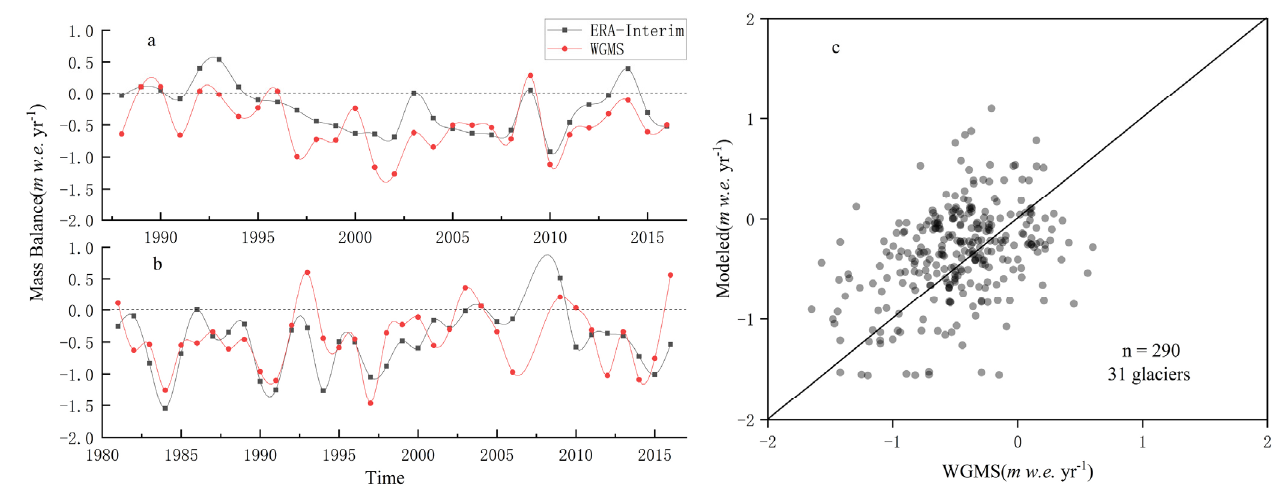
Figure 2. Accuracy evaluation of the PyGEM simulated data. Comparison of the average annual mass balance between the PyGEM-Interim simulated data and WGMS observed data. ( a ) Urumqi Glacier No. 1 E-Branch during 1988–2016, ( b ) Ts.Tuyuksuyskiy during 1981–2016, and ( c ) all the 31 glaciers.